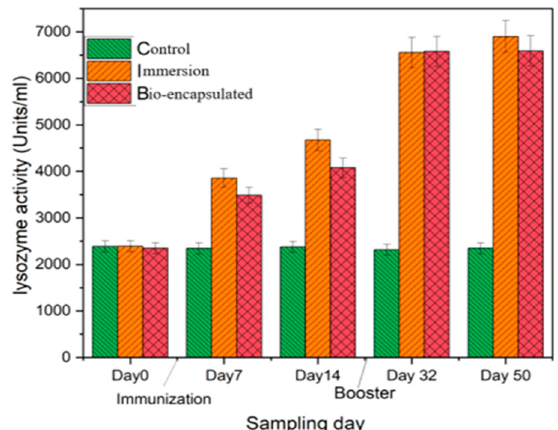
Figure 10. Intestinal tissue lysozyme activity of the juvenile Cyprinus carpio L. in three groups, control, bio-encapsulated and immersion at day 0, 7, 14, 32 and 50.